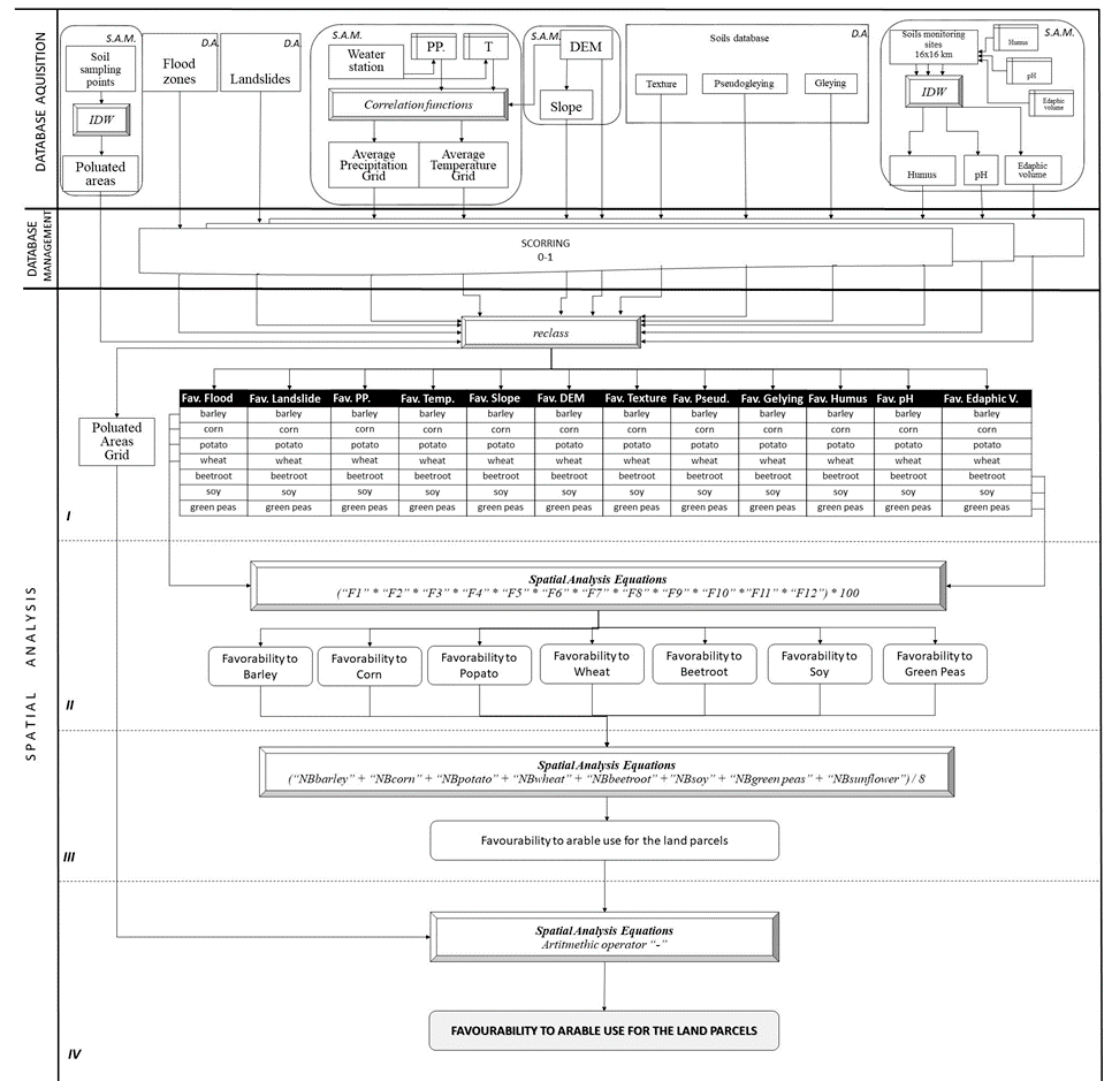
Figure 2. Conceptual schematics of the applied model.